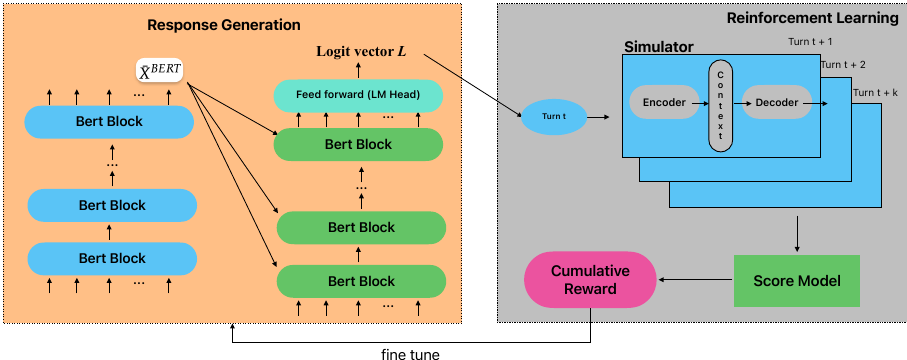
Figure 4. Bi-directional context for response generator using deep reinforcement